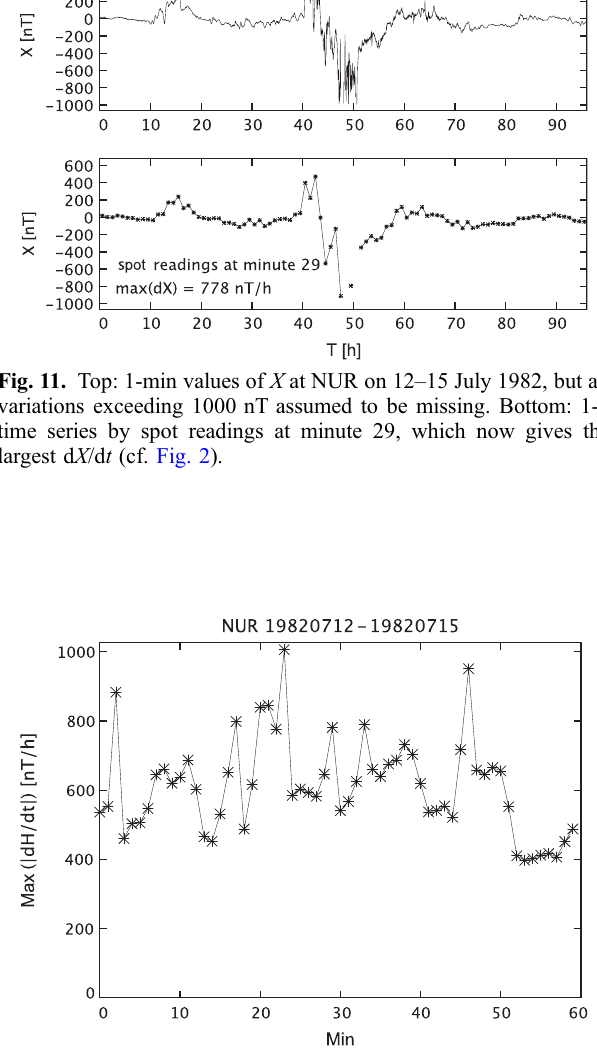
Fig. 12. Maximum hourly |d H /d t | at NUR on 12–15 July 1982 when assuming an off-scale limit as in Figure 11. The horizontal axis is the minute used for the hourly spot readings (cf. Fig.